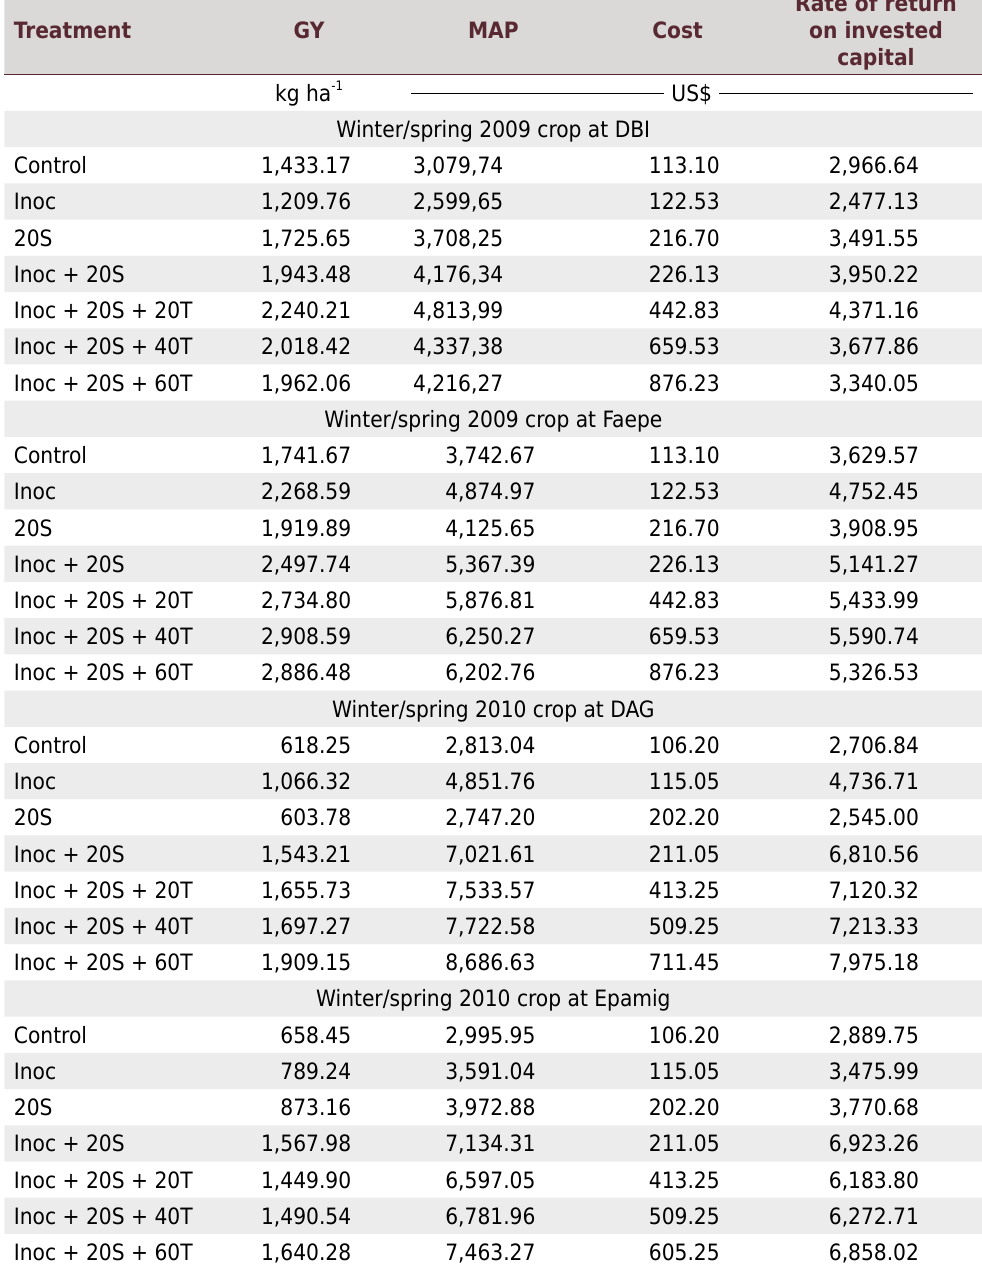
Table 5. Grain yield (GY), monetary amount of production (MAP), cost, and rate of return on invested capital at DBI and Faepe in 2009, DAG in 2010, and Epamig in 2010 during the harvest Treatment GY MAP Cost